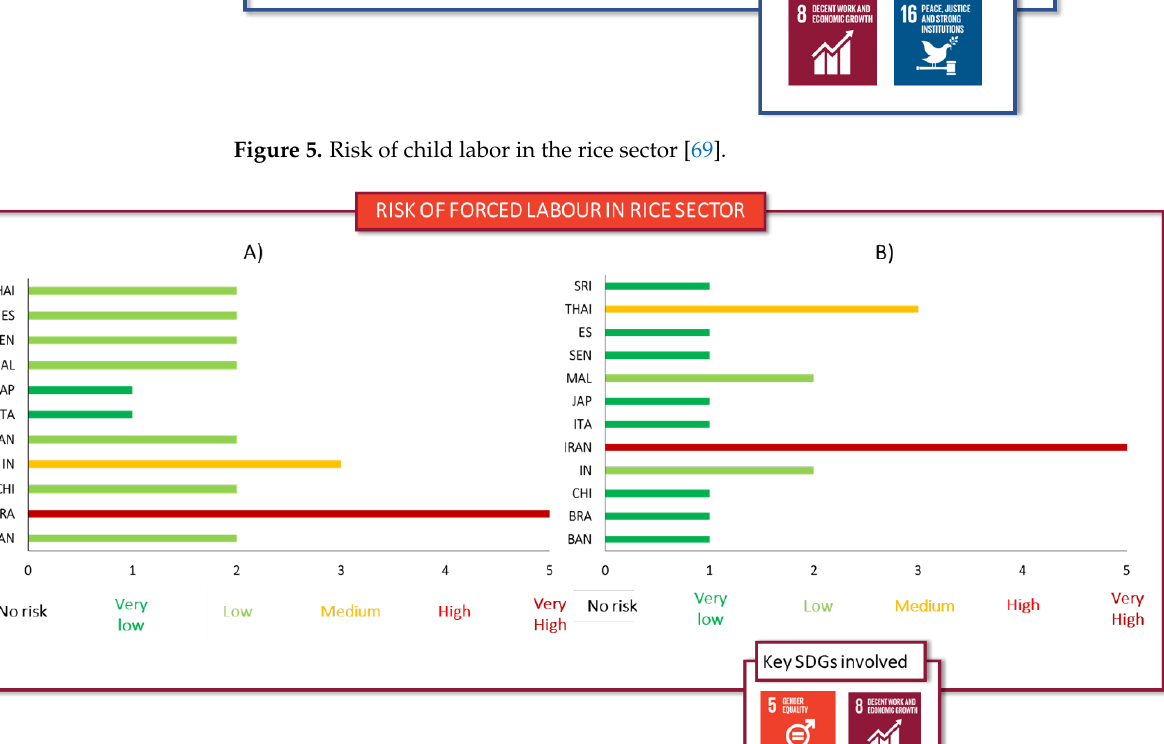
Figure 5. Risk of child labor in the rice sector [69].